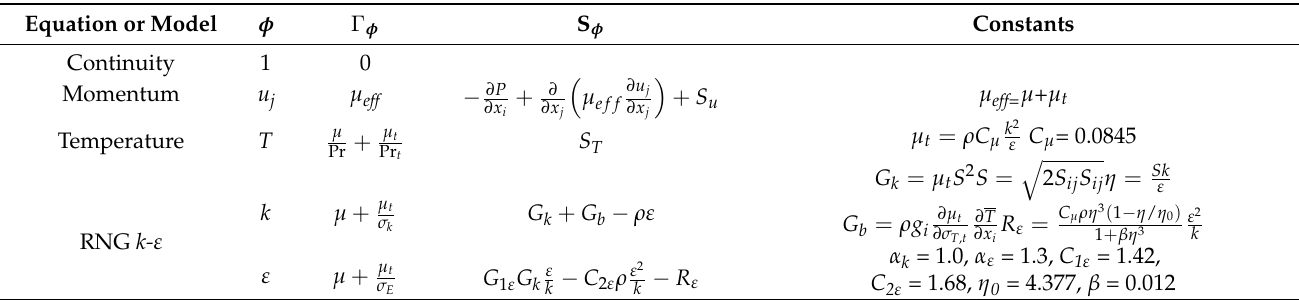
Table 1. Summary of coefficients in Equation